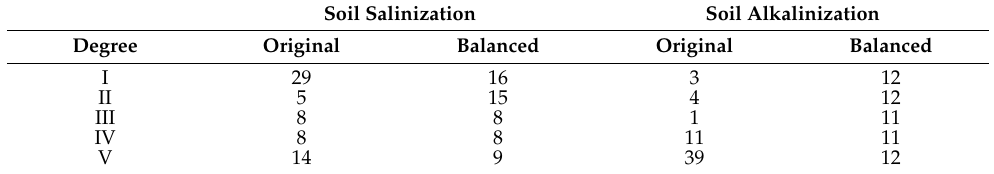
Table 4. The number of observations in different degrees under balanced and imbalanced